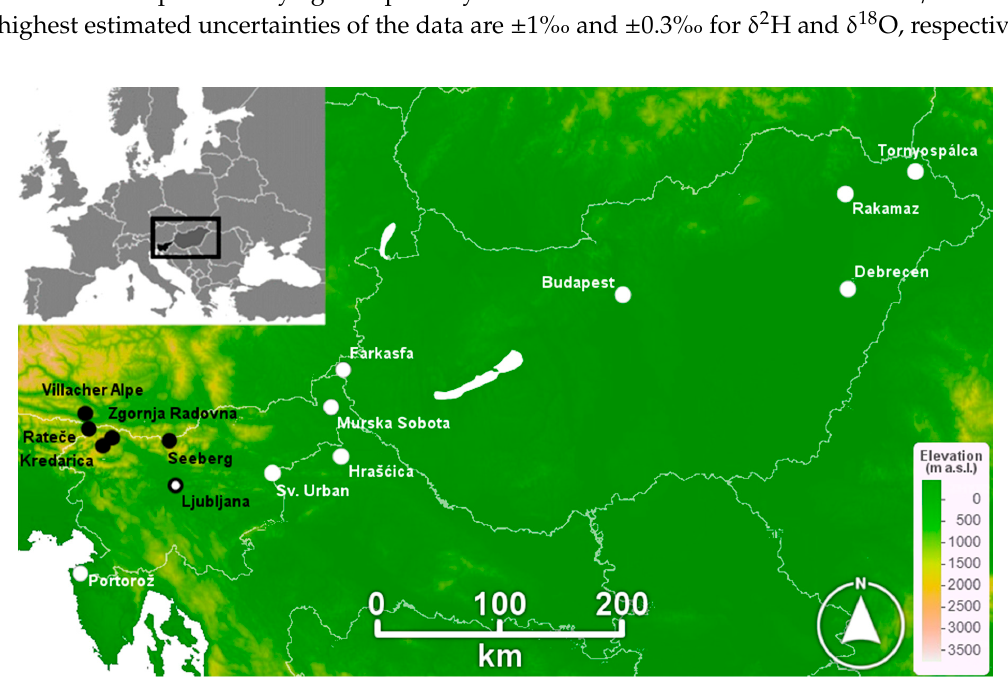
Figure 1. The study area and the location of the precipitation stable isotope monitoring stations. The sites used in the evaluation of the ‘continental‘ effect are indicated by white dots, while the ones used in studying the ‘altitude’ effect are indicated by black dots; Ljubljana was used in both. Site details can be found in Table 1. The black rectangle in the inset map of Europe shows the position of the studied region. Country map of Europe by FreeVectorMaps.com. Digital elevation model taken from http://srtm.csi.cgiar.org/.